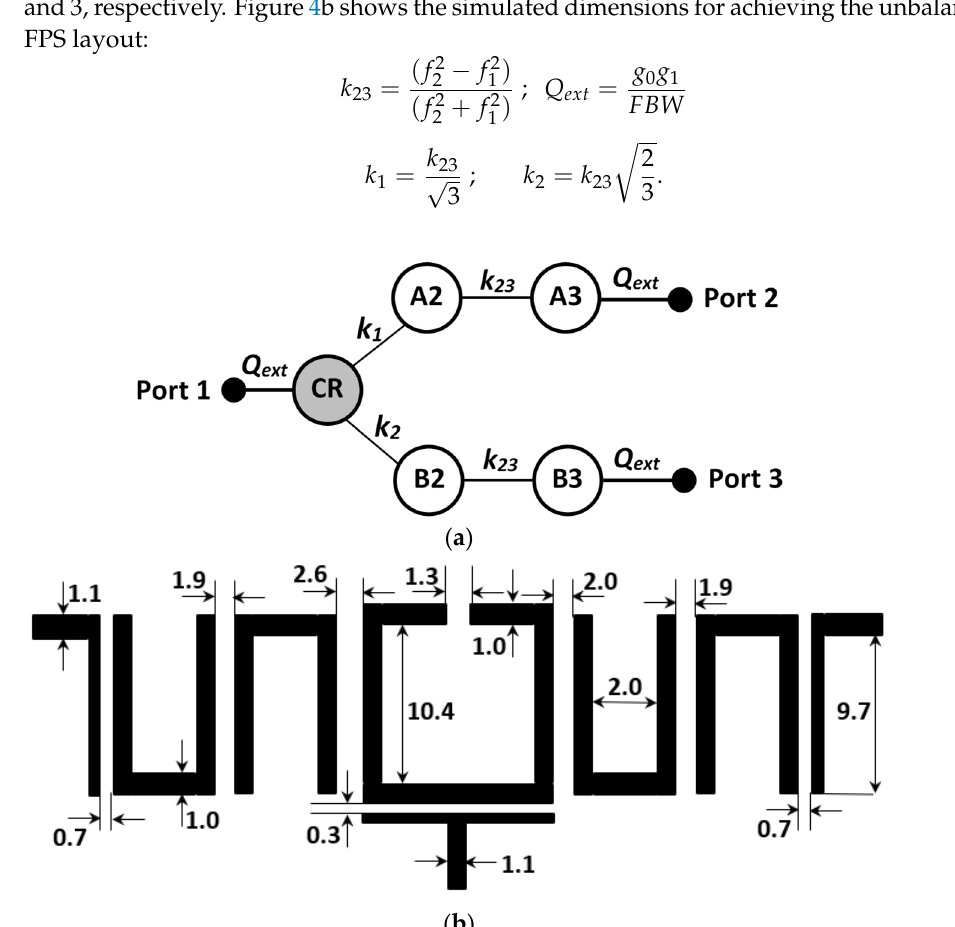
Figure 4. Unbalanced two-way filtering power splitter: ( a ) Coupling scheme with Q ext = 28.387, k 23 = 0.031, k 1 = 0.018, and k 2 = 0.025; ( b ) microstrip layout with all dimensions in mm.